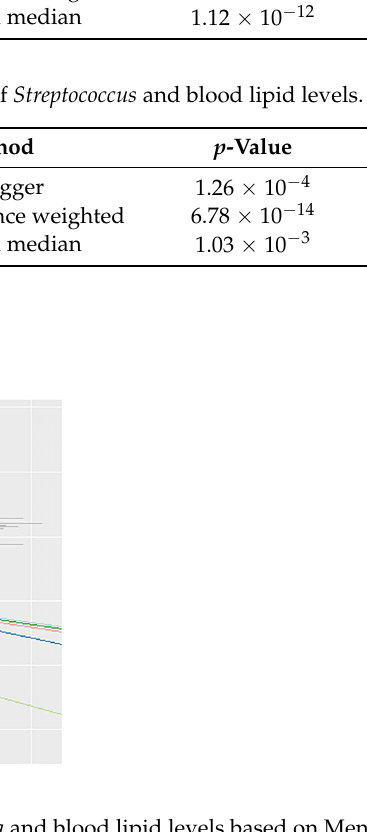
Figure 7. Causality analysis of Bifidobacteria and blood lipid levels based on Mendelian randomiza- tion. The x -axis represents the effect value associated with SNP and Bifidobacteria , and the y -axis represents the effect value associated with SNP and LDL and levels in the blood.